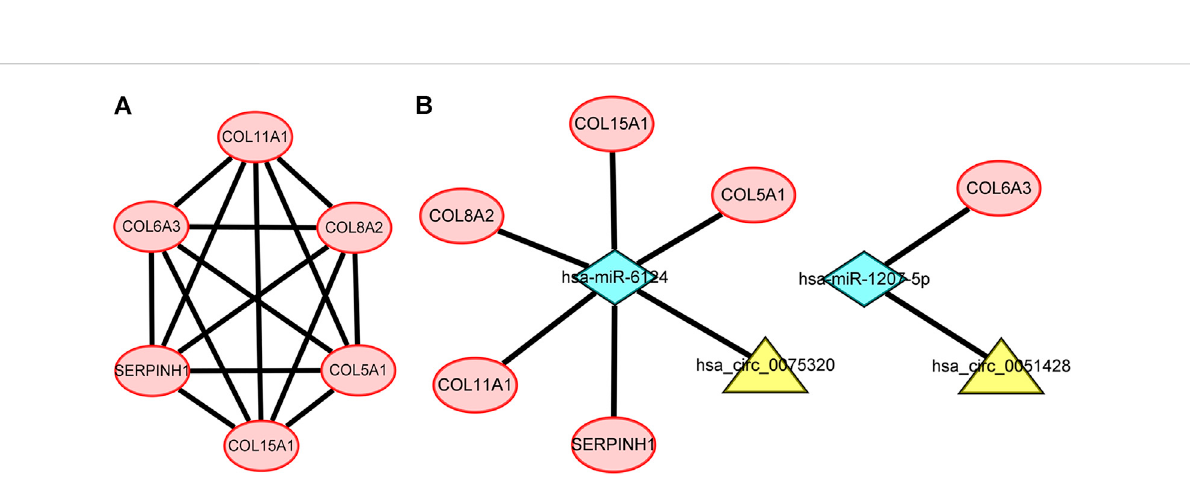
FIGURE 7 (A) PPI network consisting of the six hub genes. (B) A subnetwork of circRNAs – miRNAs – hub